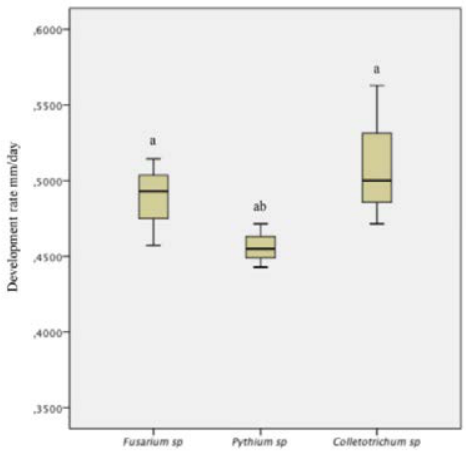
Fig. 1. (A) Macronidia of Fusarium sp., to 100X; (B) Conidiomas of Colletotrichum sp., to 100X; (C) Oogonia to Pythium sp., to 100X.